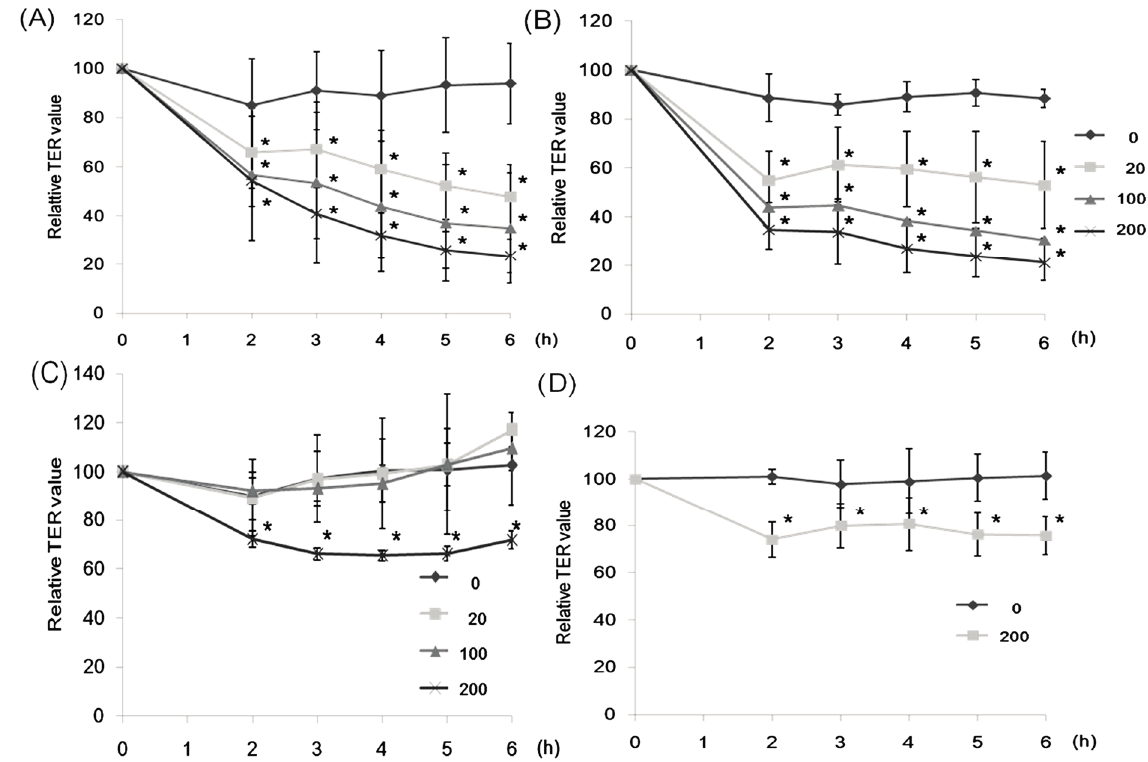
Figure 4. Effects of CGA and WGA on TER values of Caco-2 cell monolayers. The cell monolayers were incubated with CGA (20–200 µg/mL) ( A ) or WGA (20–200 µg/mL) ( C ) for 6 h. TER values were measured periodically during incubation. After incubation with CGA or WGA for 2 h, 10 mM D-glucose ( B ) and 10 mM N -acetyl- D -glucosamine ( D ) were added to the apical side, respectively. Results are shown as a percentage of the control (without lectin) values, and are the means ± SD of three different determinations. * p < 0.05 compared with the control values at 2 h.